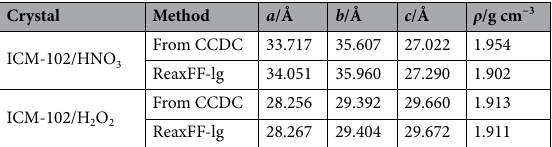
Table 1. Comparison of the lattice parameters and densities of ICM-102/HNO 3 and ICM-102/H 2 O 2 .